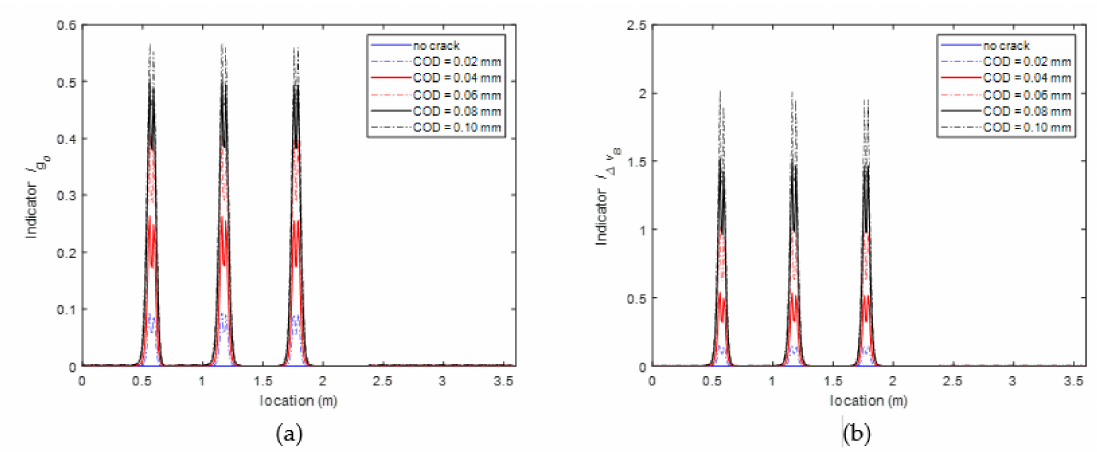
Figure 12. Parameter values of I g ( b ) I ∆ v B